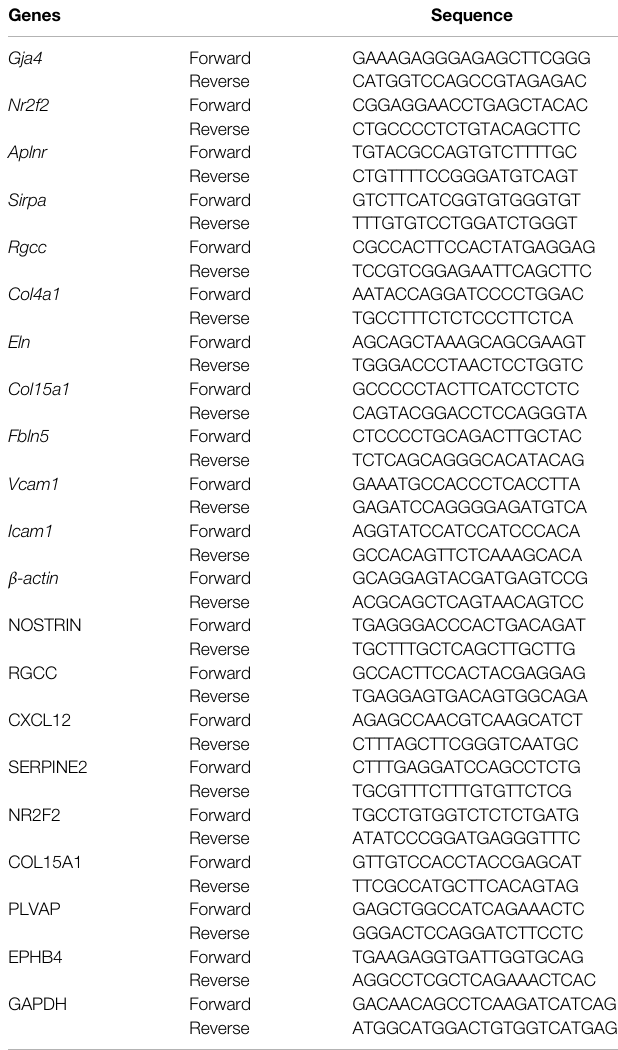
TABLE 2 | Primer sequences used in